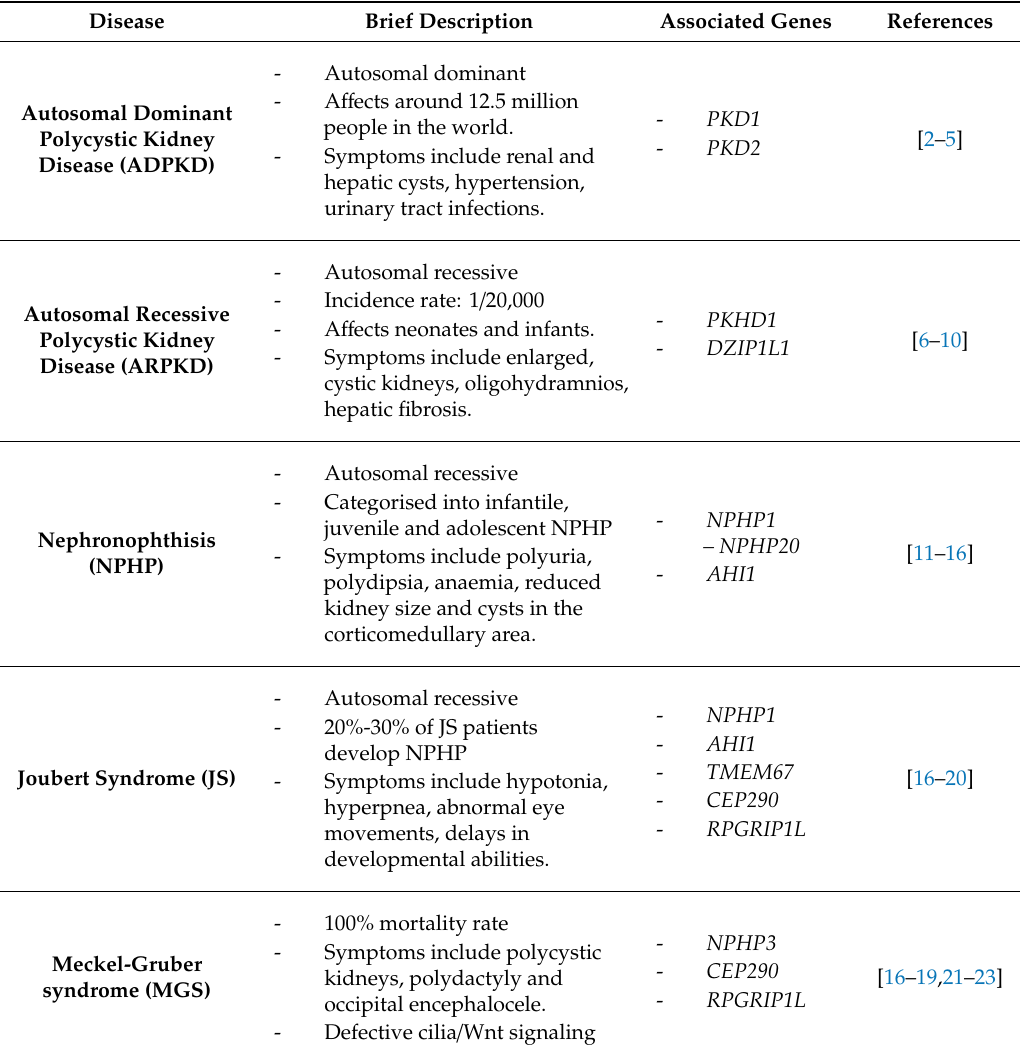
Table 1. A brief summary, including symptoms and associated genes of the reported genetically inherited chronic kidney